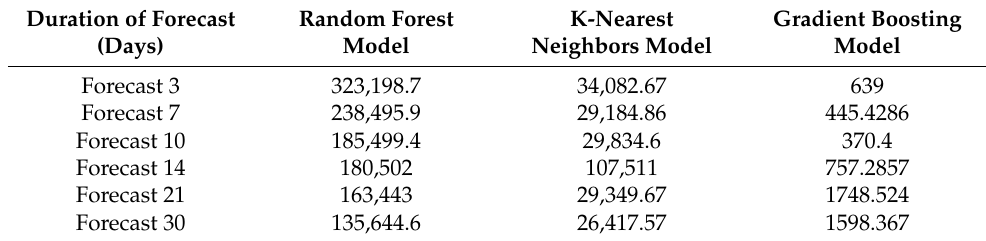
Table 5. Mean absolute error of forecasted cumulative new cases for Germany (number of